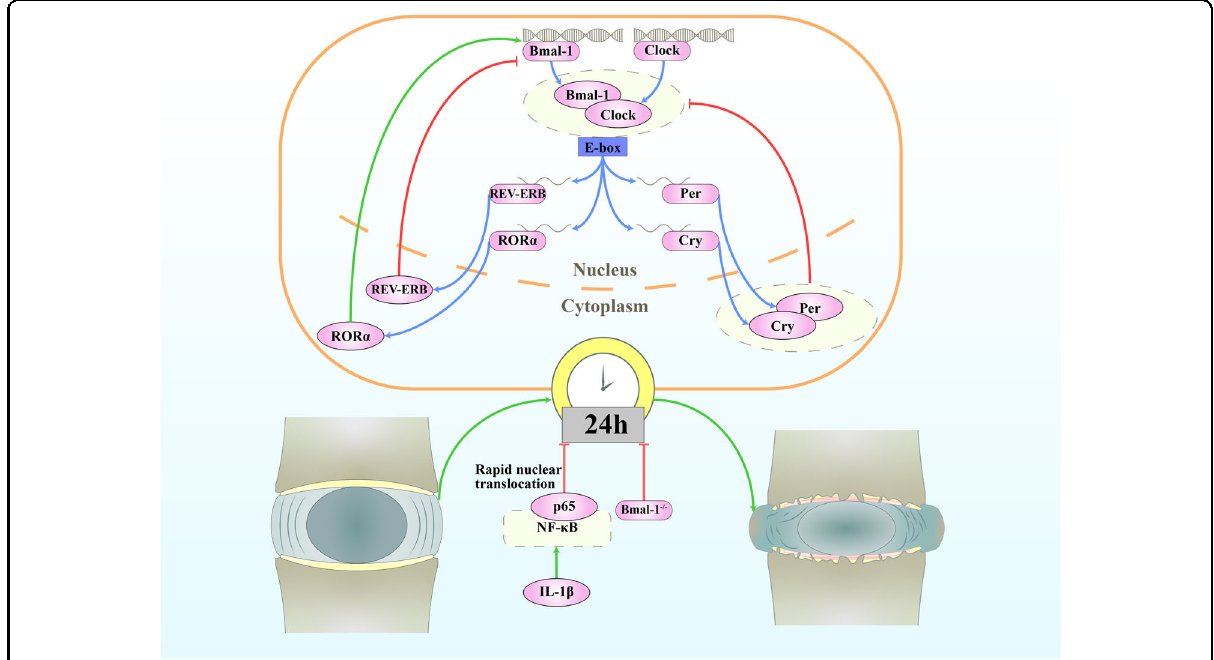
Fig. 1 The circadian rhythm in intervertebral disc degeneration. The amplitude of the oscillations in IVDs from aged mice is attenuated, with decreased expression of the core circadian transcription factors BMAL1 and CLOCK. Knockout of Bmal1 in mice IVD cells leads to the widespread degeneration of lumbar IVDs. Bone bridges appear within the growth plate, the CEP is almost completely replaced by bone, and the height of the disc is signi fi cantly reduced. Disorganization of the outer annulus structure and signs of fi brosis (with organized collagen bundles) appear at the periphery of the IVDs. IL-1 β causes the rapid nuclear translocation of p65 in both AF and NP cells and leads to a loss of pacemaking properties of individual